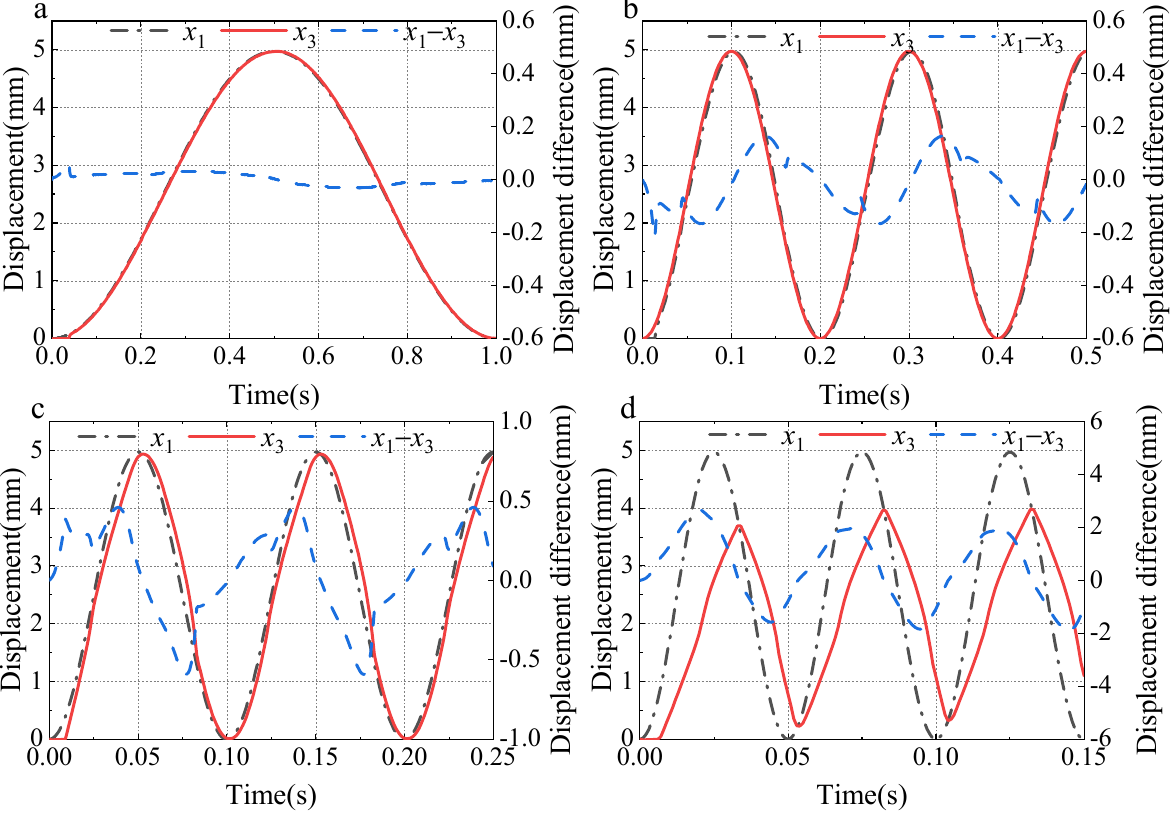
Figure 17. The frequency response characteristics of the proportional valve: ( a ) 1 Hz; ( b ) 5 Hz; ( c ) 10 Hz; ( d ) 20 Hz.